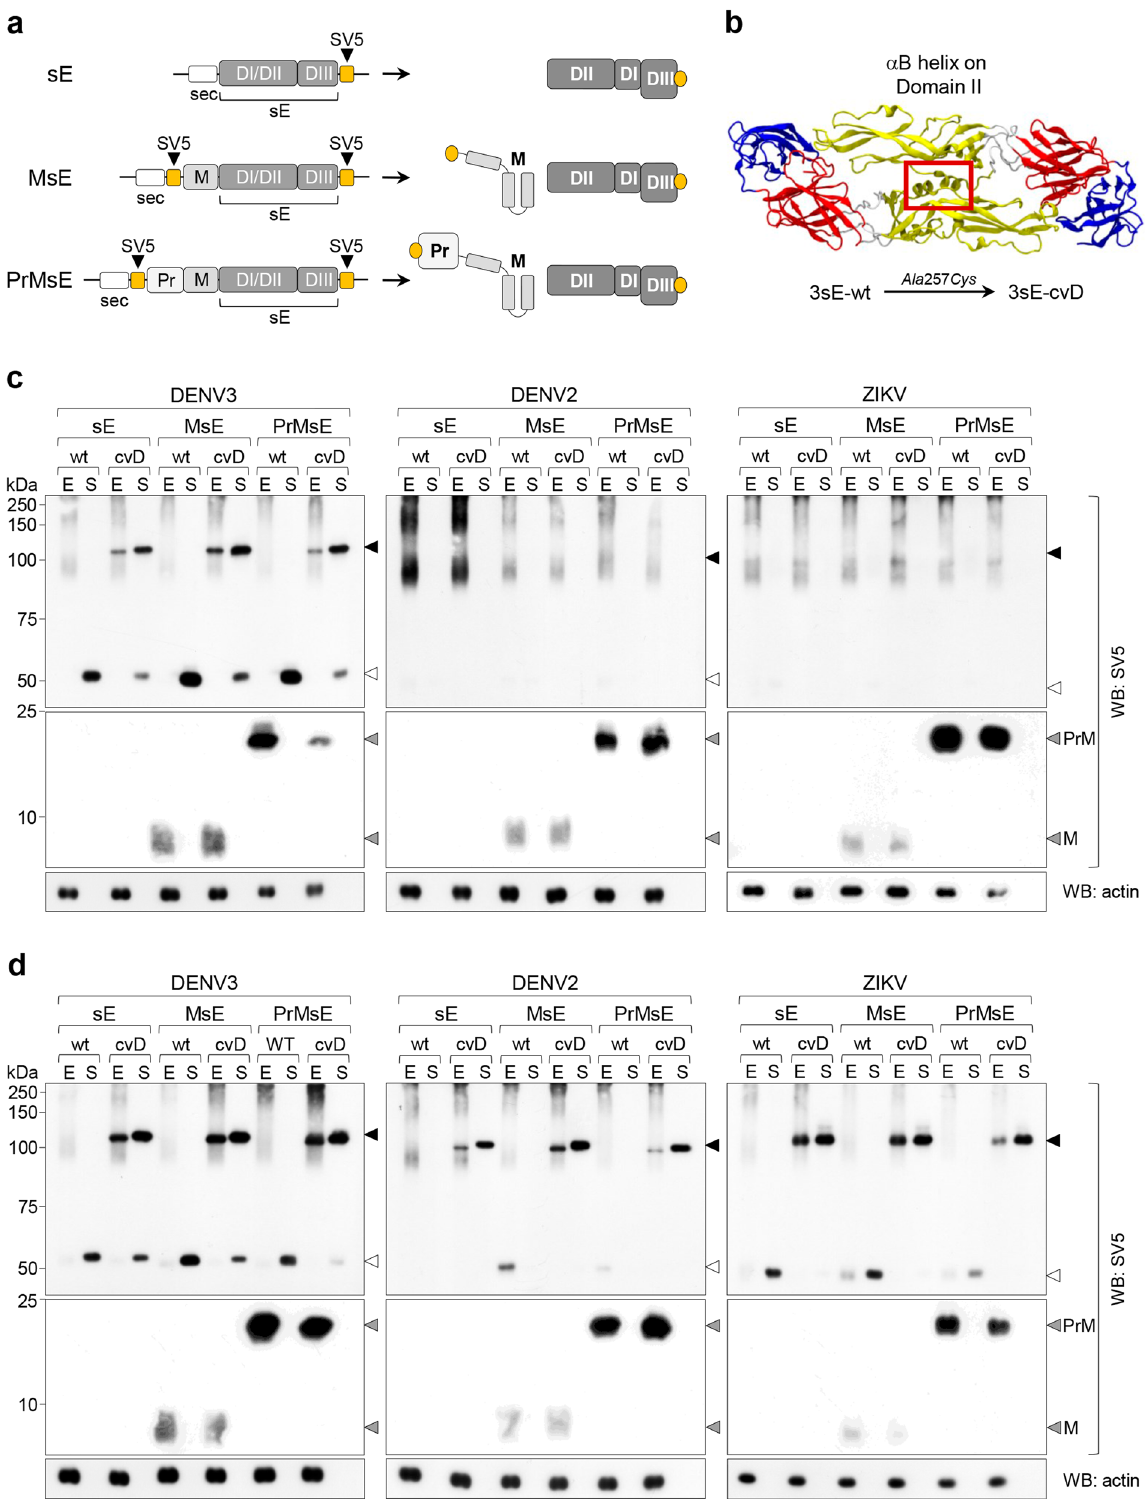
Figure 1. Dimerization and secretion of DENV and ZIKV sE proteins in mammalian cells. ( a ) Schematic representation of constructs and expected products. ( b ) Dimeric structure of DENV serotype 3 sE (PDB reference 1uzg) indicating the position of the α B helix where the Ala257Cys mutation was introduced. ( c , d ) Non-reducing western blots of total cell extracts (E) and culture supernatants (S) of HEK-293T cells transfected with the indicated constructs and incubated at 37 °C ( c ) or at 28 °C ( d ). Open and filled arrowheads indicate monomeric and dimeric sE,